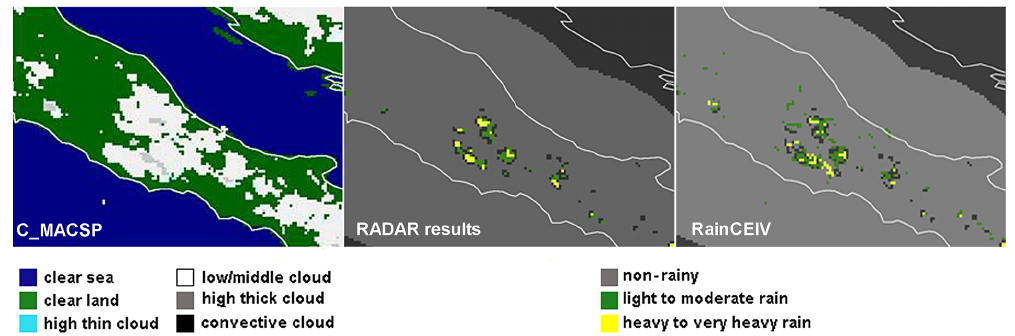
Figure 4. 4 August 2010 at 14:15UTC. From left to right: C_MACSP cloud classification results, radar-derived rain rate results, RainCEIV rain rate results.